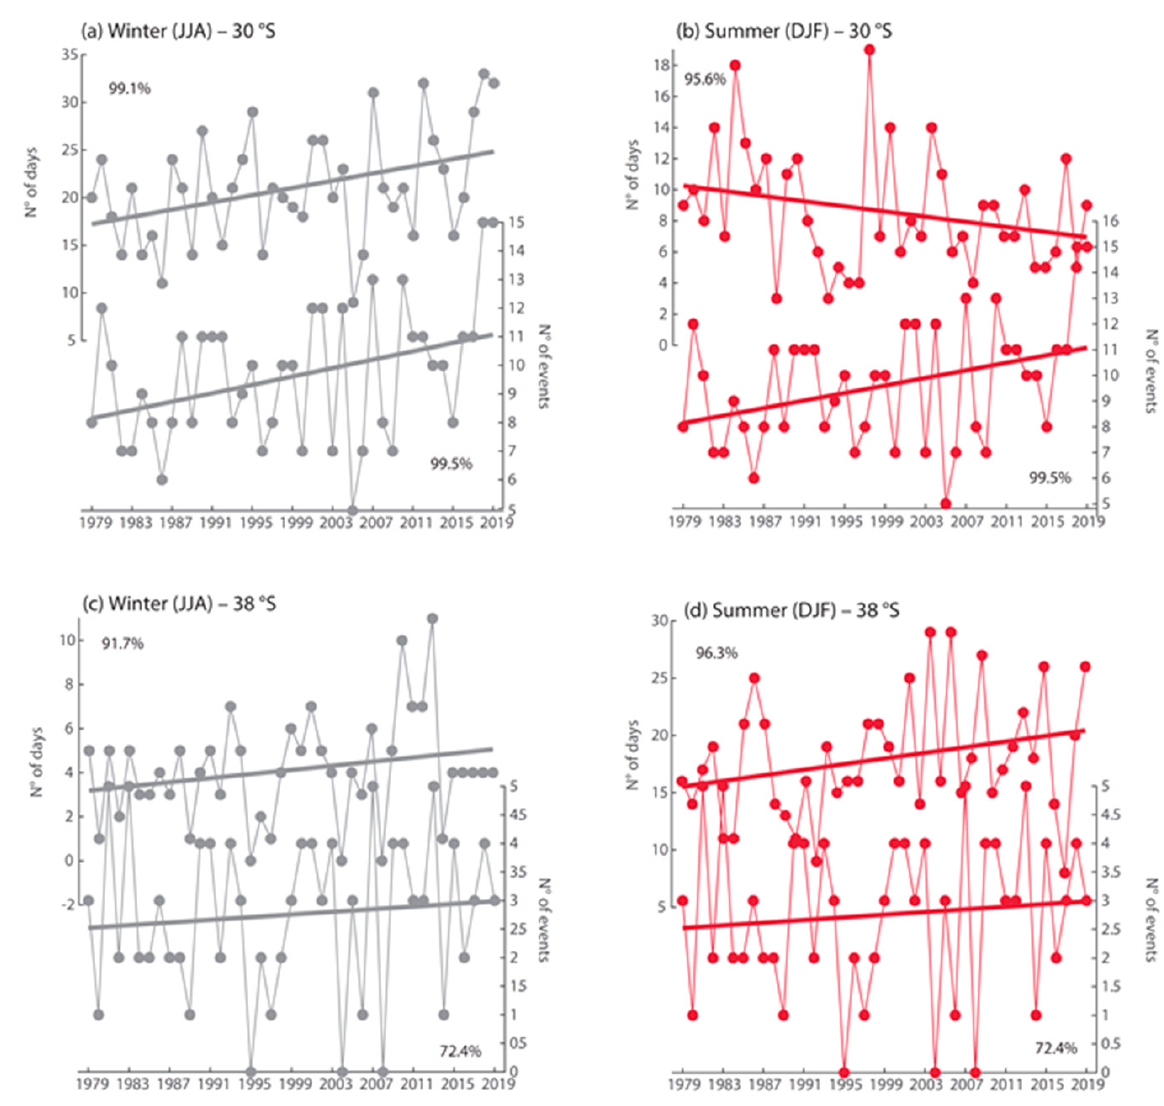
Figure 8. Time series at selected locations of number of windy days and number of CLLJ events, ( a ) at 30 °S for winter, ( b ) at 30 °S for summer, ( c ) at 38 °S for winter and ( d ) at 38 °S for summer.